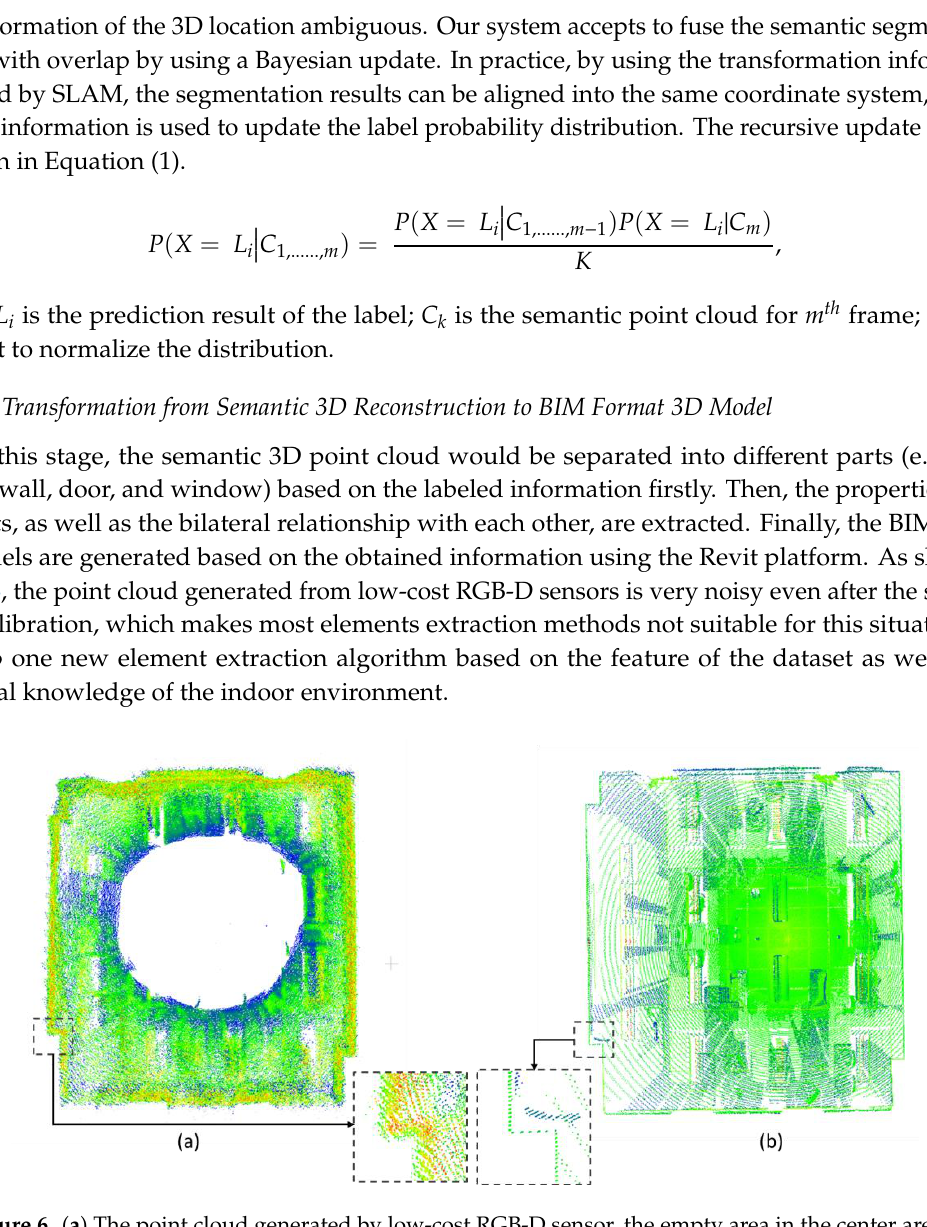
Figure 6. ( a ) The point cloud generated by low-cost RGB-D sensor, the empty area in the center area is caused by the data collection trajectory, ( b ) is the point cloud generated by terrestrial laser scanner (TLS).